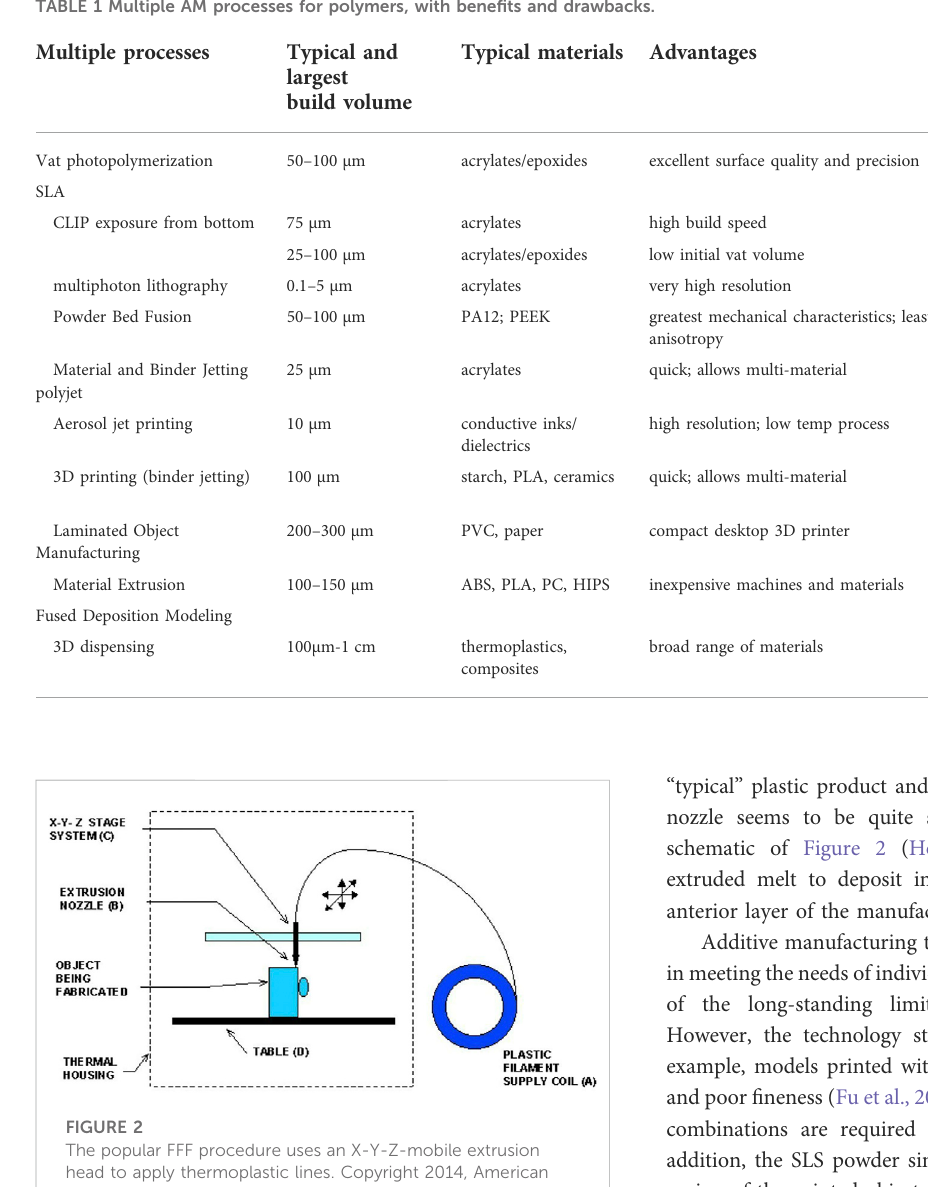
TABLE 1 Multiple AM processes for polymers, with bene fi ts and drawbacks.